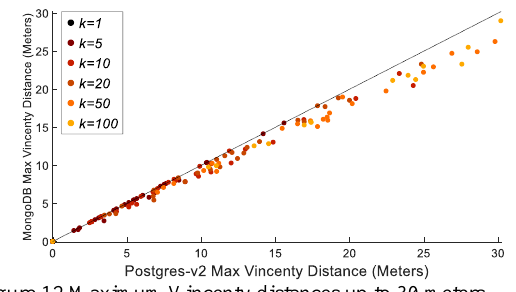
Figure 12 Maximum Vincenty distances up to 30 meters